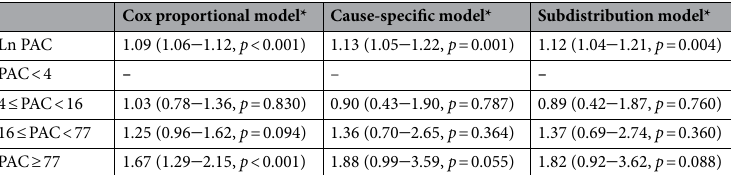
Table 3. Multivariate survival analyses of all-cause mortality and competing risk of cardiovascular death. *Adjusted for age, gender, DM, hypertension, CAD, CKD, HF, stroke, aspirin, and ACEi/ARB. Abbreviations: ACEi/ARB angiotensin-converting enzyme inhibitor/angiotensin receptor blocker, CAD coronary artery disease, CKD chronic kidney disease, DM diabetes mellitus, HF heart failure, HR hazard ratio, PAC premature atrial